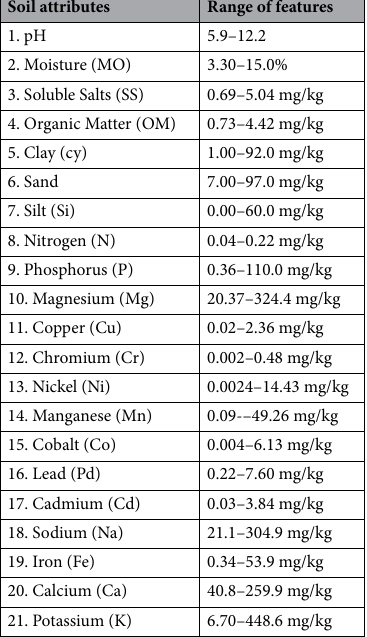
Table 2. Range of various Pysical and Chemical Soil